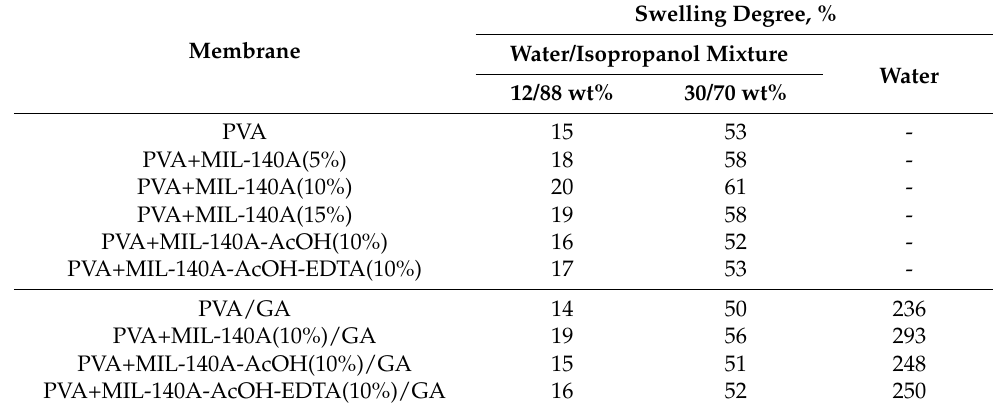
Table 3. Swelling degree of the uncross-linked and cross-linked PVA and PVA/Zr-MOFs membranes in water and water/isopropanol (12/88 and 30/70 wt%) mixtures. Membrane